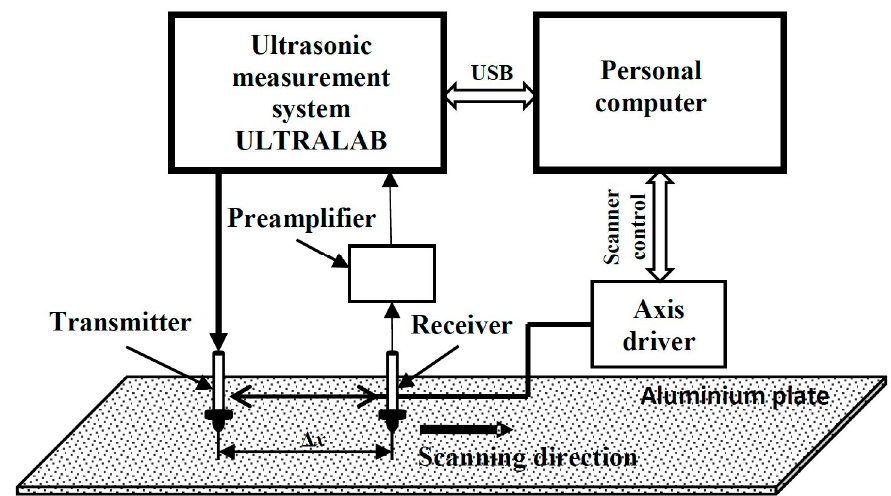
Figure 8. The experimental setup for generating and receiving Lamb wave signals on an aluminum plate.